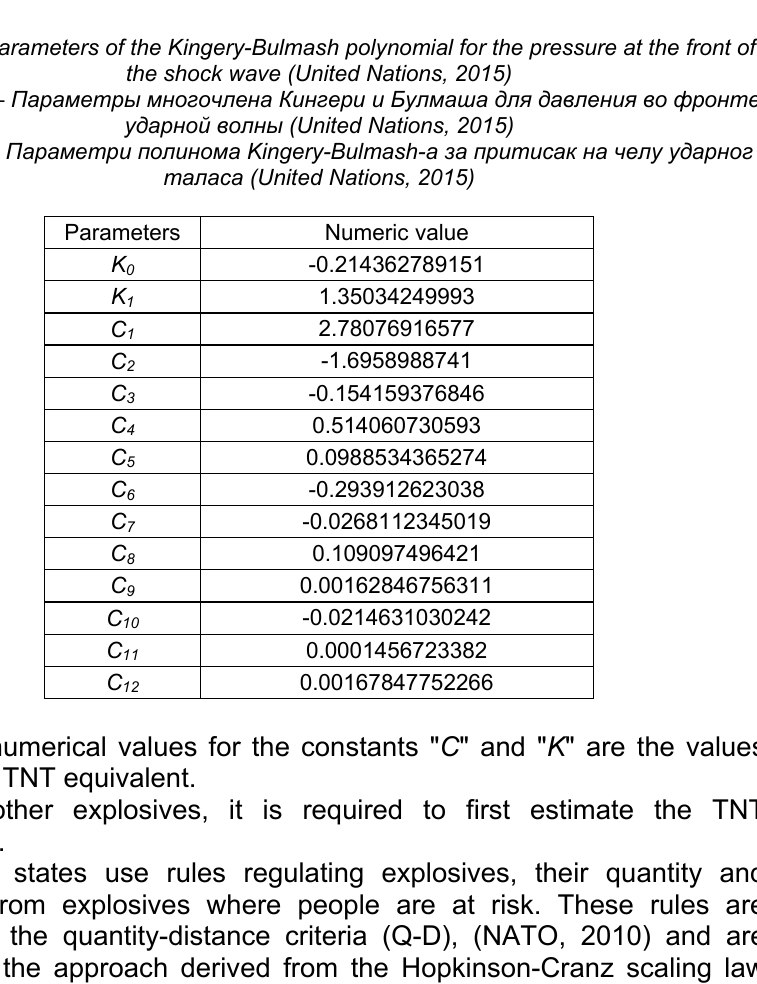
Table 5 – Parameters of the Kingery-Bulmash polynomial for the pressure at the front of the shock wave (United Nations,